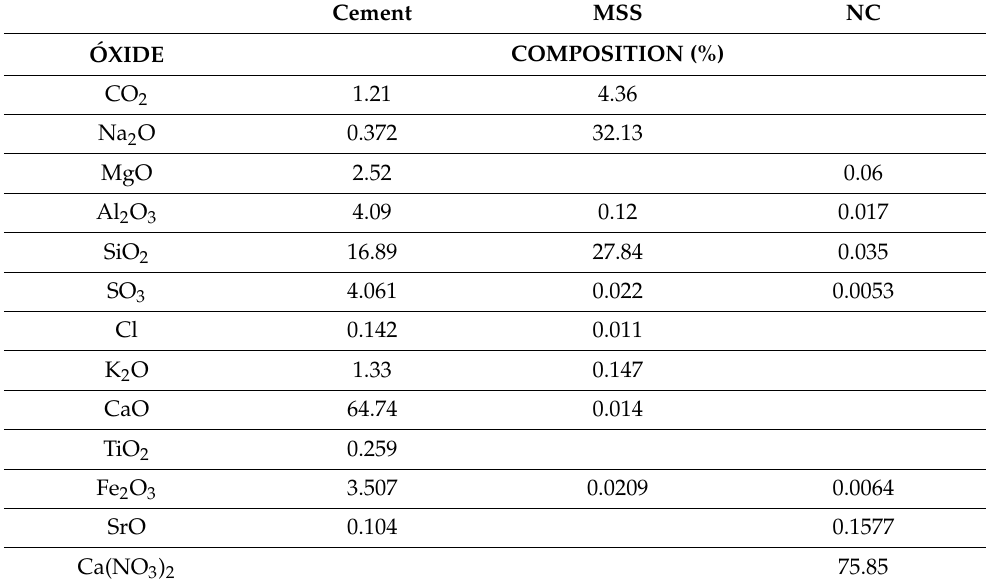
Table 1. Chemical composition of majority